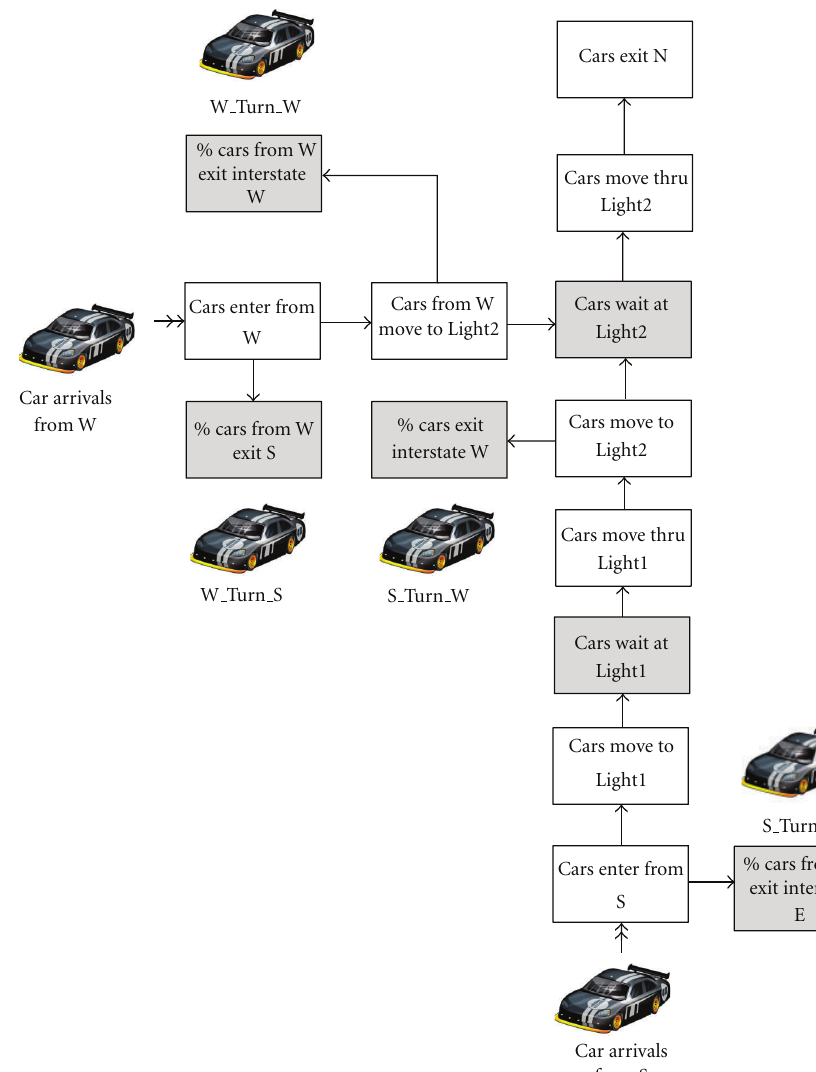
Figure 3: Tra ffi c flow